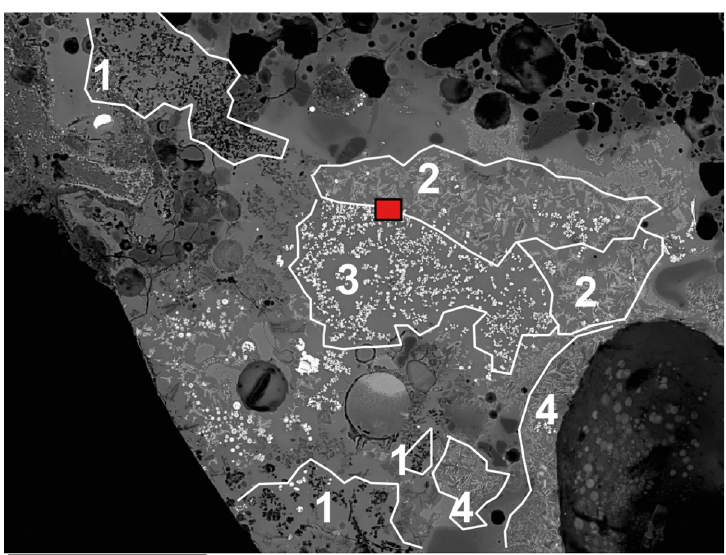
Fig 7. BSE micrograph of G11 showing clusters of Ca-rich minerals (1), cuprite skeletal formations (2), metallic copper (3) and delafossite(4). The red square shows the image zoomed-in on Fig 10. (Scale = 240 μ m).